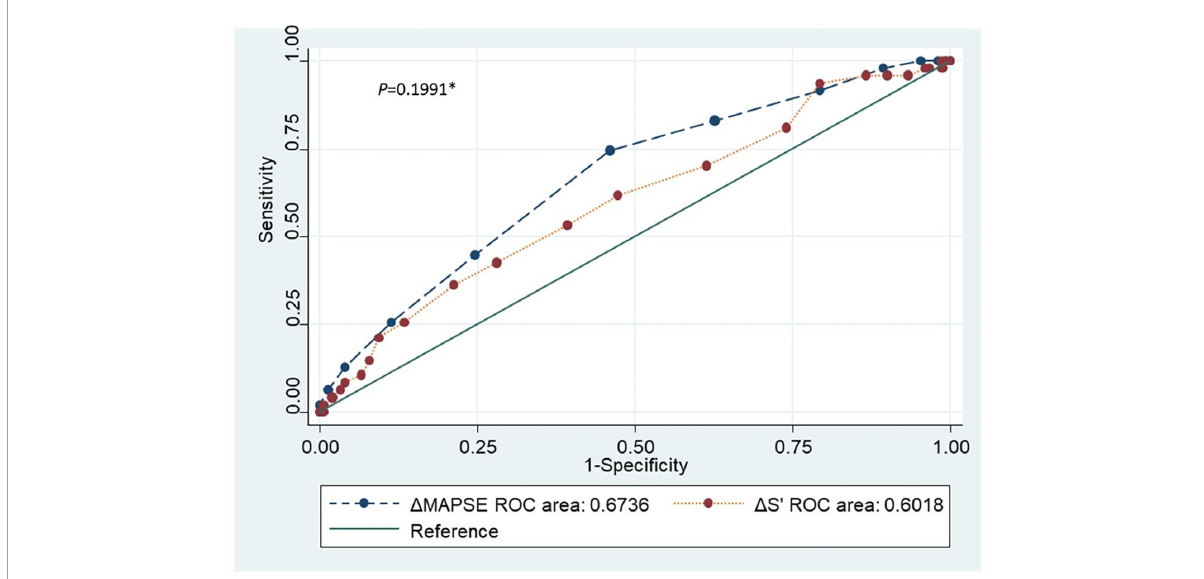
FIGURE5 Receiver operating characteristic curve comparing the two conventional echocardiographic parameters ( (cid:49) MAPSE and (cid:49) S’). ROC, Receiver operating characteristic; (cid:49) MAPSE, Reduction of mitral annular plane systolic excursion; (cid:49) S’, Reduction of mitral annular peak systolic tissue Doppler velocity. ∗ p -value comparing the accuracy of the 2 conventional echocardiographic parameters.